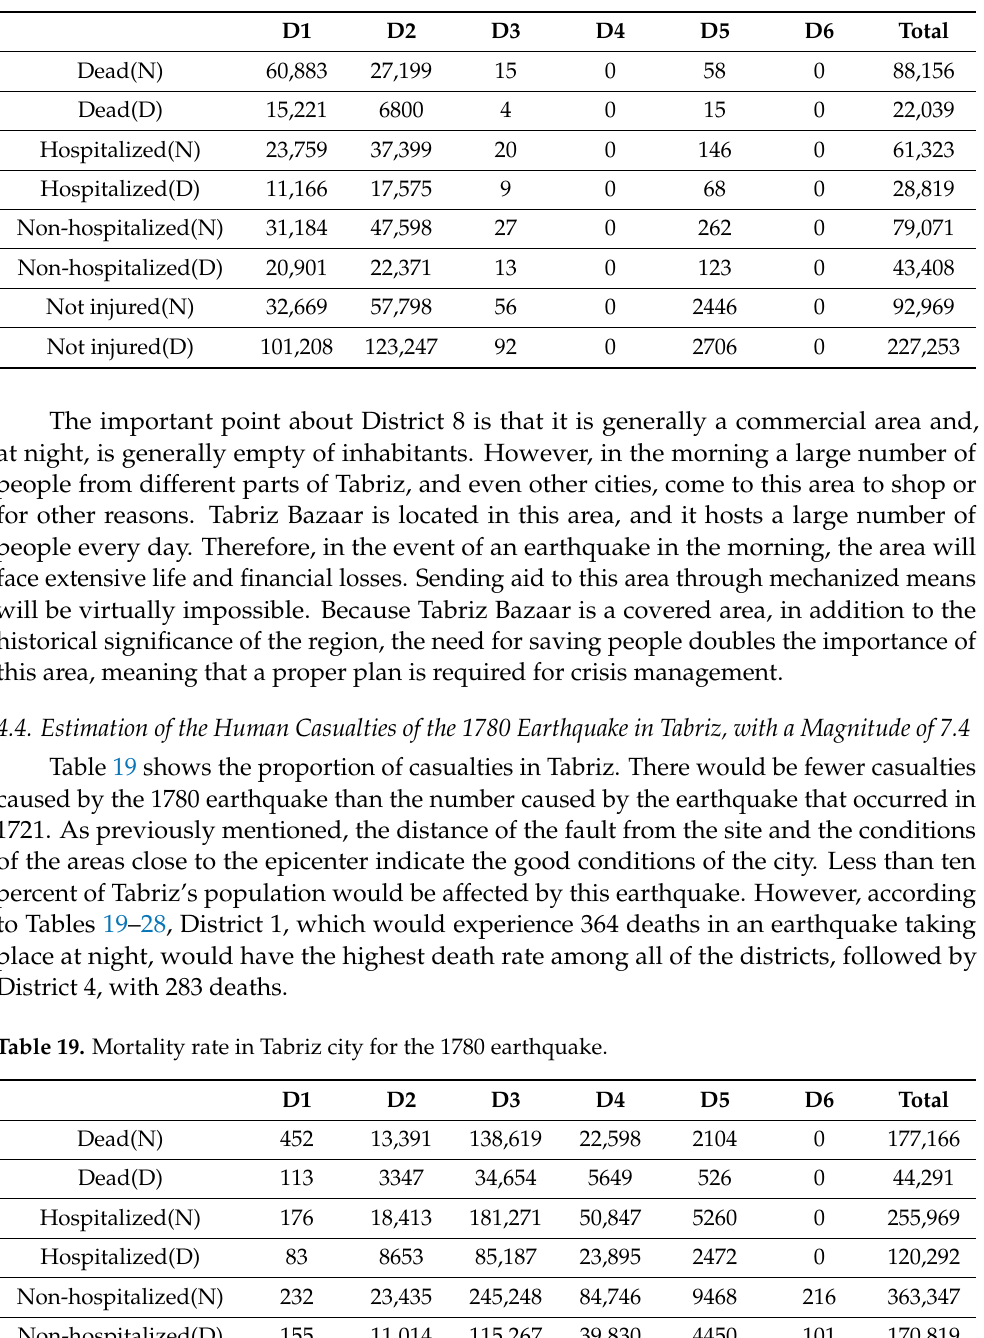
Table 18. Number of casualties in the 1721 earthquake in District 10 of Tabriz.